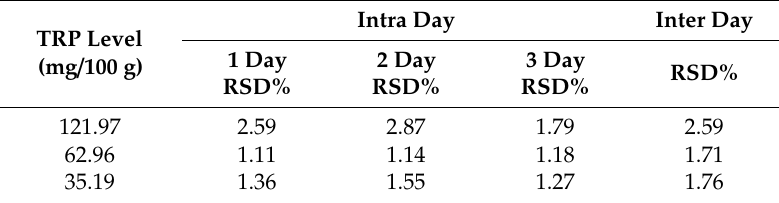
Table 3. Repeatability and reproducibility performances on yoghurt samples.